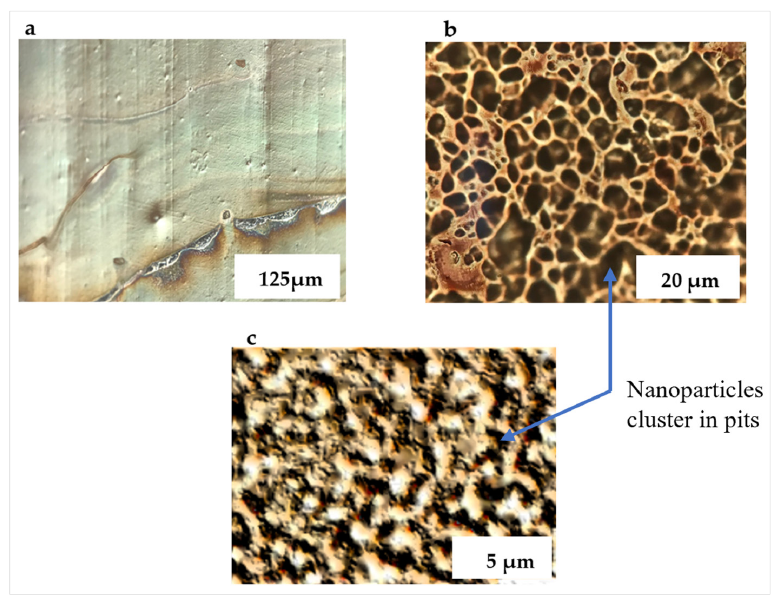
Figure 3. Optical micrographs of deposited nanoparticle suspension. ( a ) Ag nanoparticles on non- imprinted PETE congregate along the rim of a circle; ( b ) isolated islands of Ag nanoparticles form on 6 µ m grit imprinted PETE; ( c ) much smaller islands of Ag nanoparticles form on 1 µ m grit imprinted PETE.